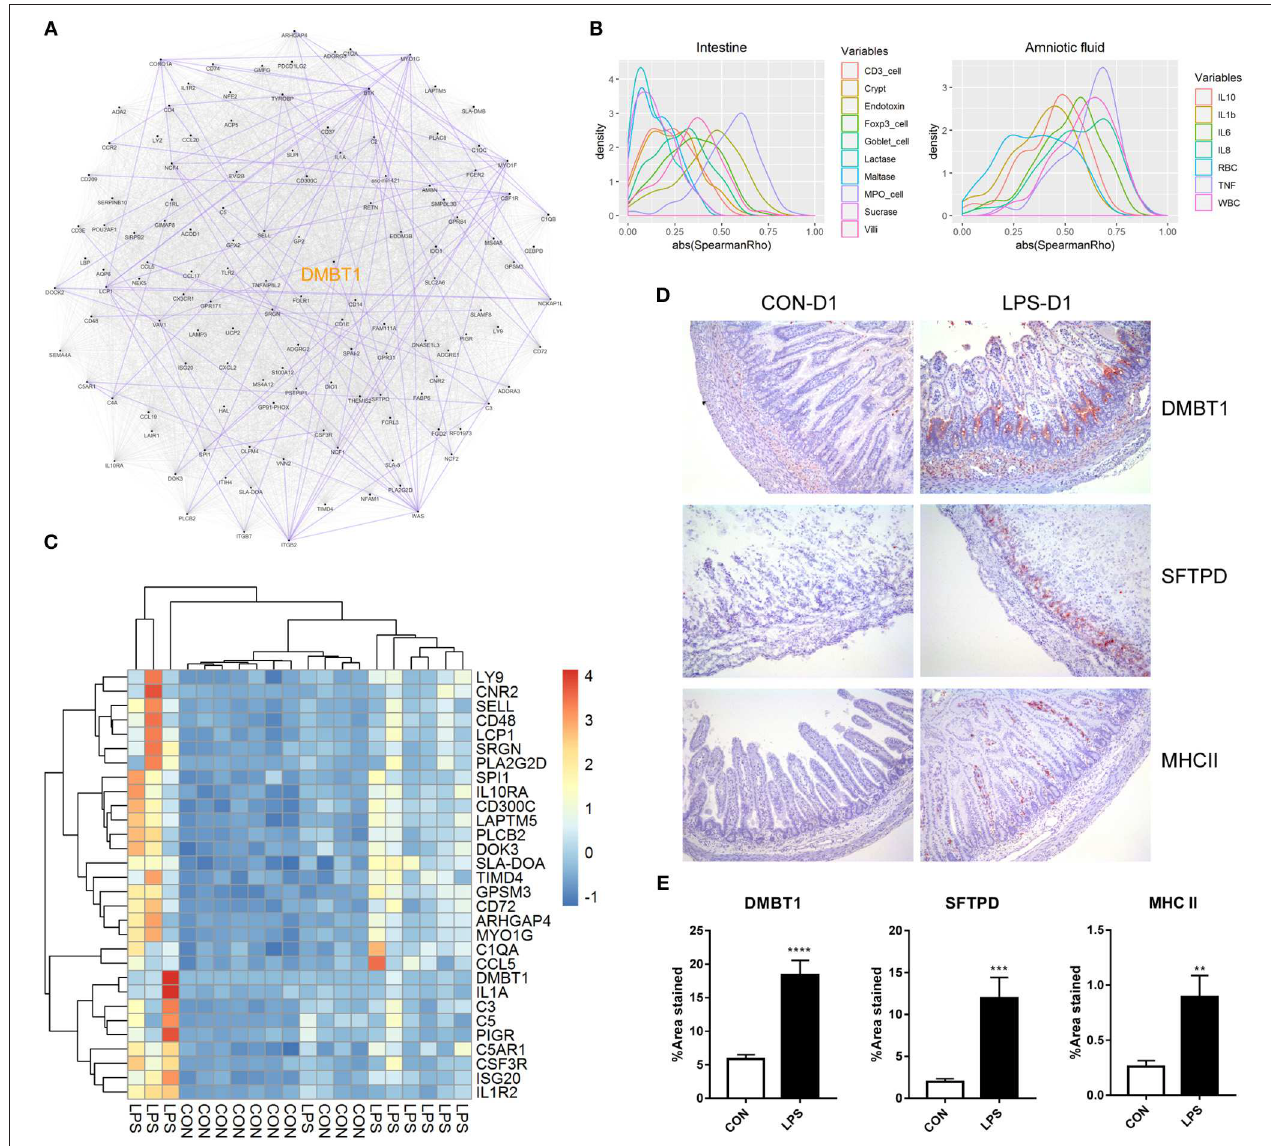
FIGURE 3 | Relationship and functionality of DEGs between LPS and CON groups at birth. (A) Putative co-expression network, where each node represents a gene, and each edge represents a significant correlation between gene pairs. Experimentally determined protein–protein interaction between gene pairs is highlighted in purple. Hub gene DMBT1 is highlighted in yellow. (B) Density plot of absolute Spearman ρ between DEGs and intestinal/amniotic measures. (C) Heatmap showing the relative expression of DEGs that were correlated with intestinal MPO-positive cell density and amniotic TNF- α level. (D) Representative images of distal small intestines stained with antibodies to DMBT1, SFTPD, and MHCII. (E) Significant difference of the area stained by DMBT1/SFTPD/MHCII between LPS and CON groups was revealed according to Mann–Whitney U test. Values are presented as the mean ± SEM, * P < 0.05, ** P < 0.01, *** P < 0.001, **** P < 0.0001.